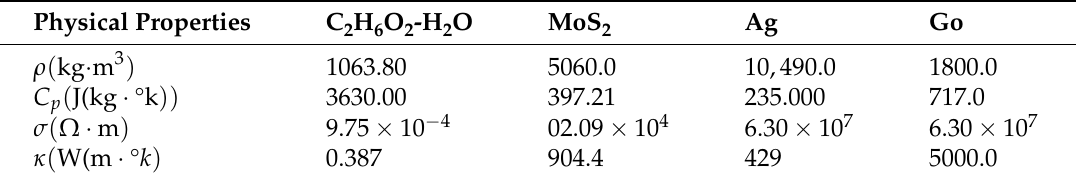
Table 1. Thermo-physical properties of hybrid base fluid and nanoparticles